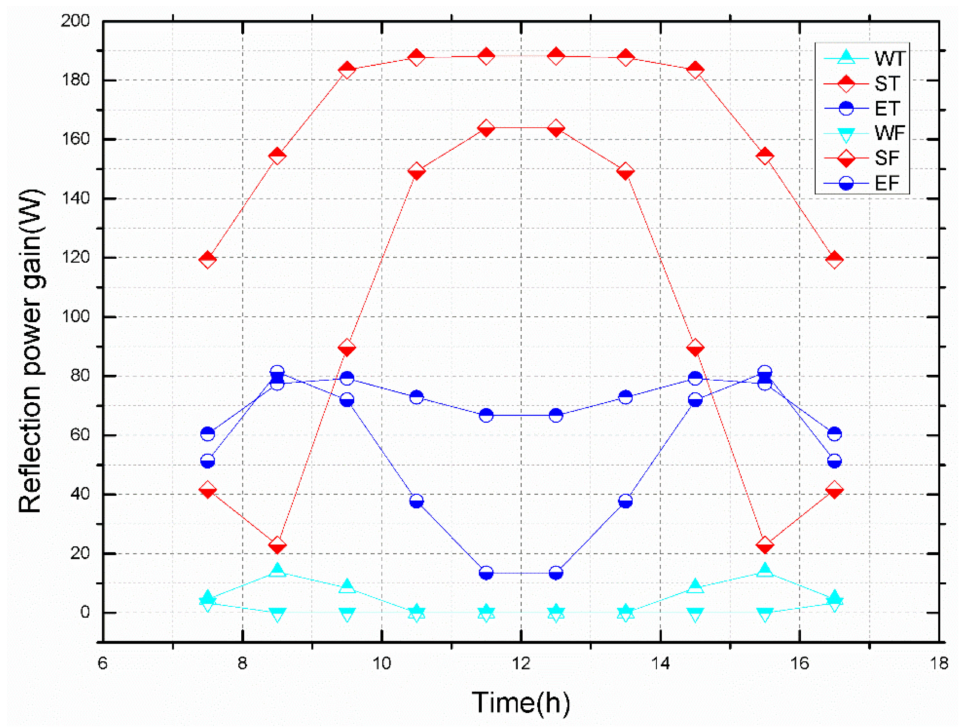
Figure 9. Variation in the power generated by reflected light ( E rear_2 ) of the single-module system with time.